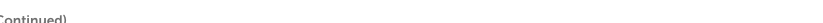
FIGURE1(Continued) maps represent measurements below the 99th and 95th percentile ranges, respectively. (C) Peripapillary RNFL thickness was quantified in four regions, including the inferior (INF), superior (SUP), nasal (NAS), and temporal (TEP) regions. The line graph indicates that the detailed RNFL thickness of patients with APACG (colored in red) reduced significantly, with the contralateral unaffected eyes as the control group. * P < 0.05. (D) The bar graph shows the average GCL thickness in patients with APACG. GCL thickness increased slightly. Data are presented as mean ± SD. (E) The line graph shows that the RNFL thickness in patients with CPACG reduced significantly, and a Mann–Whitney rank sum test was used to analyze the data, * P < 0.05. (F) Macular GCL thickness in CPACG was obviously reduced. Data are presented as box-and-whisker plots, where the “box” delineates the median and the 25th and 75th quartiles and the “whiskers” show the minimum and maximum values. A two-tailed t -test was used to analyze the data, *** P < 0.001.